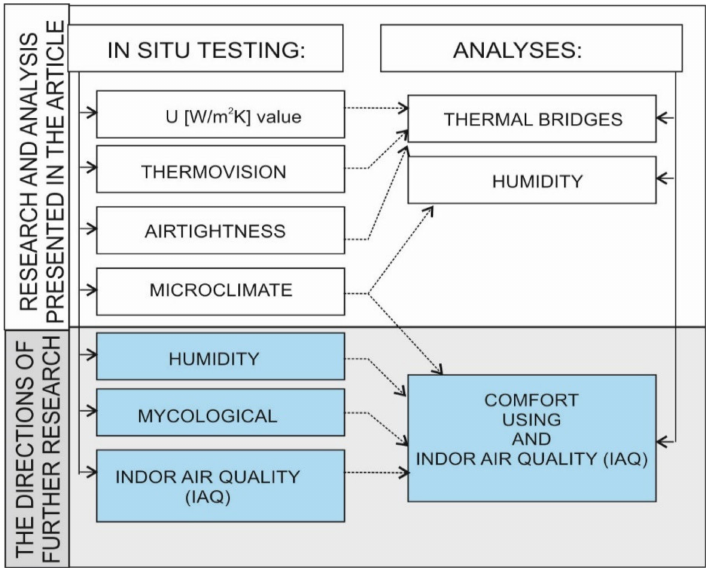
Figure 30. The directions for further